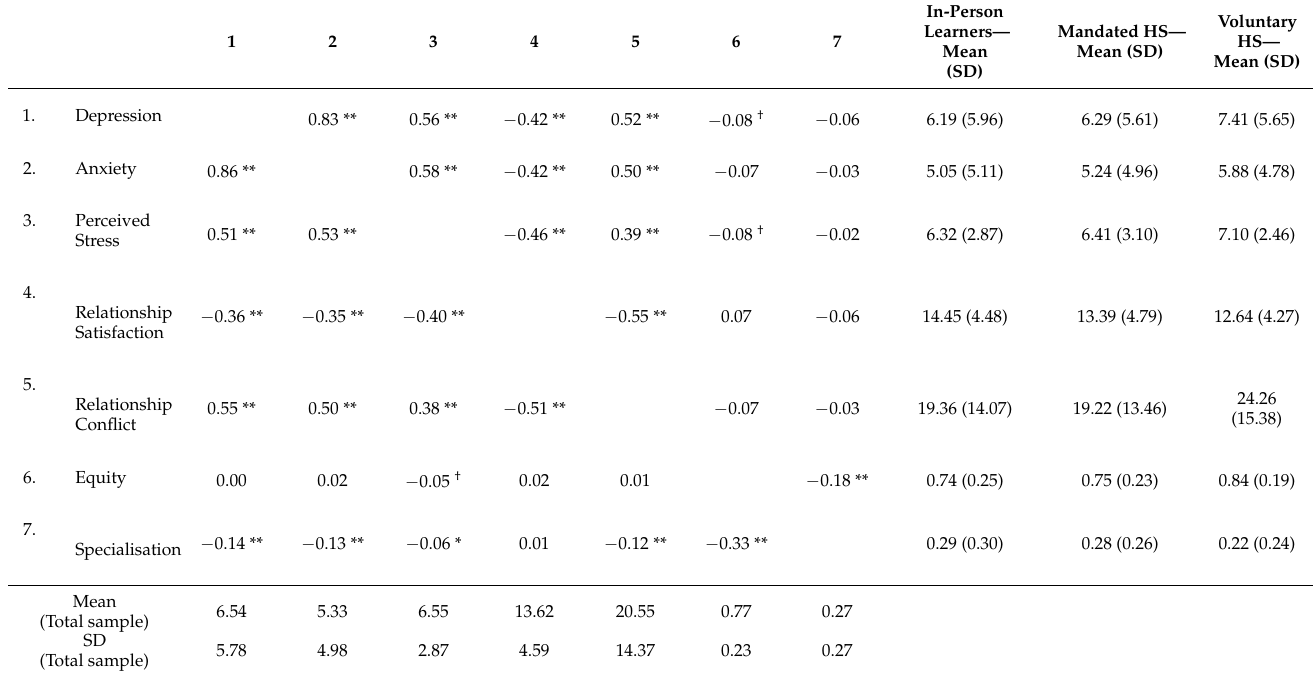
Table 2. Descriptive statistics and bivariate correlations among study